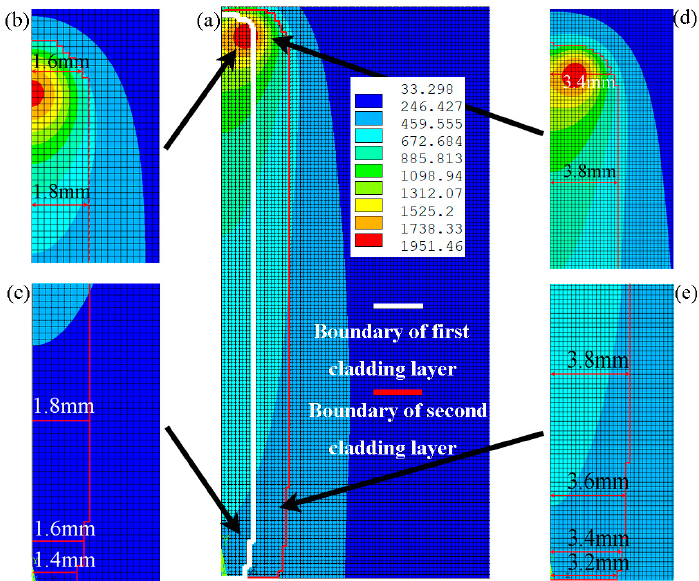
Figure 9. Diagram of the change in width of the cladding layer during the multi-track laser cladding process: ( a ) the overall morphology of multi-track laser cladding; ( b ) the rear of the first cladding layer; ( c ) the front of the first cladding layer; ( d ) the rear of the second cladding layer; and ( e ) the front of the second cladding layer.